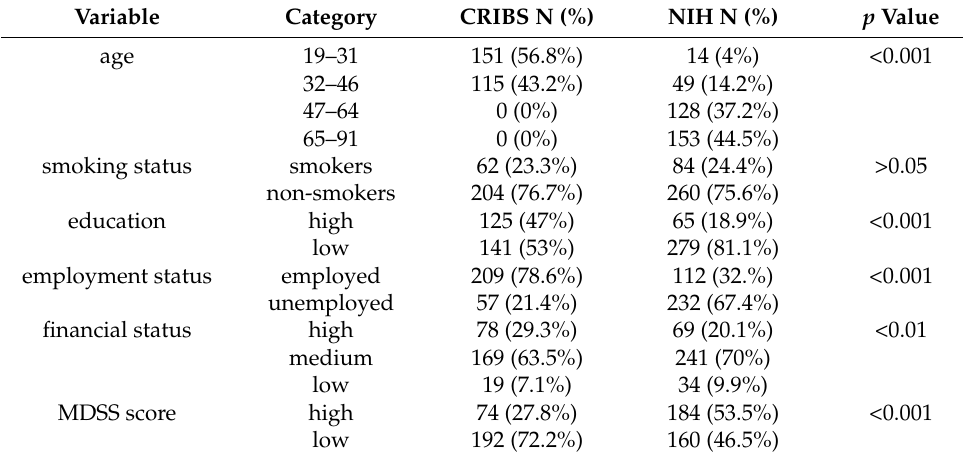
Table 1. Baseline characteristics of participants by